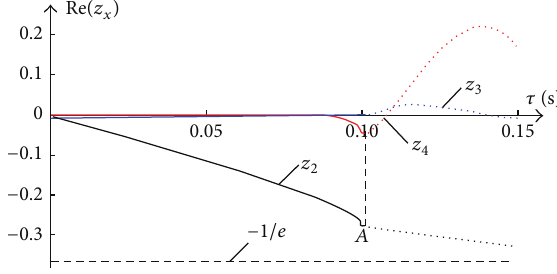
Figure 13: Curves of 𝜏 - 𝑧 2 , 𝜏 - 𝑧 3 , and 𝜏 - 𝑧 4 .